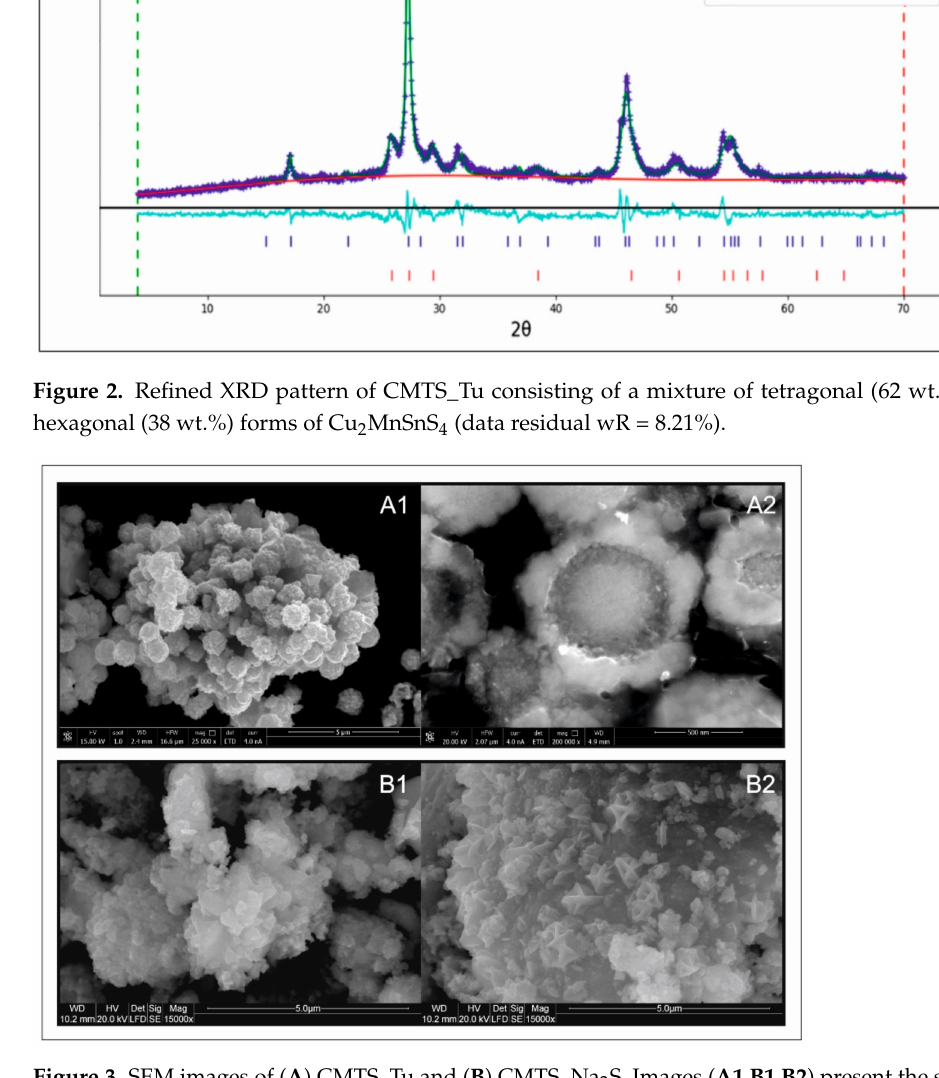
Figure 3. SEM images of ( A ) CMTS_Tu and ( B ) CMTS_Na 2 S. Images ( A1 , B1 , B2 ) present the surfaces of powder samples. Image ( A2 ) presents a polished sample to reveal the internal nanostructure of the microspheres on the